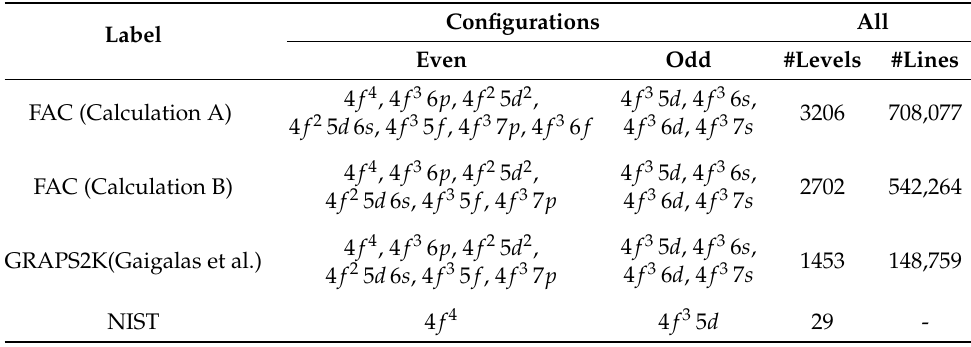
Table 1. Summary of the different set of configurations used on different calculations for Nd III, including experimental results from NIST [20]. For the GRASP2K calculations [21], only the configu- rations from the multireference space are shown. The full active space of configurations used in that calculation is shown in Ref.